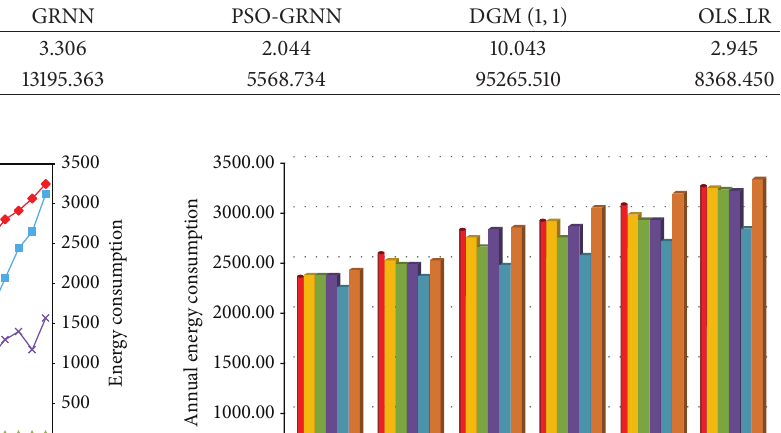
Table 2: The calculation results of MAPE and MSE of PSOCA-GRNN, GRNN, PSO-GRNN, DGM (1, 1), and OLS LR models.